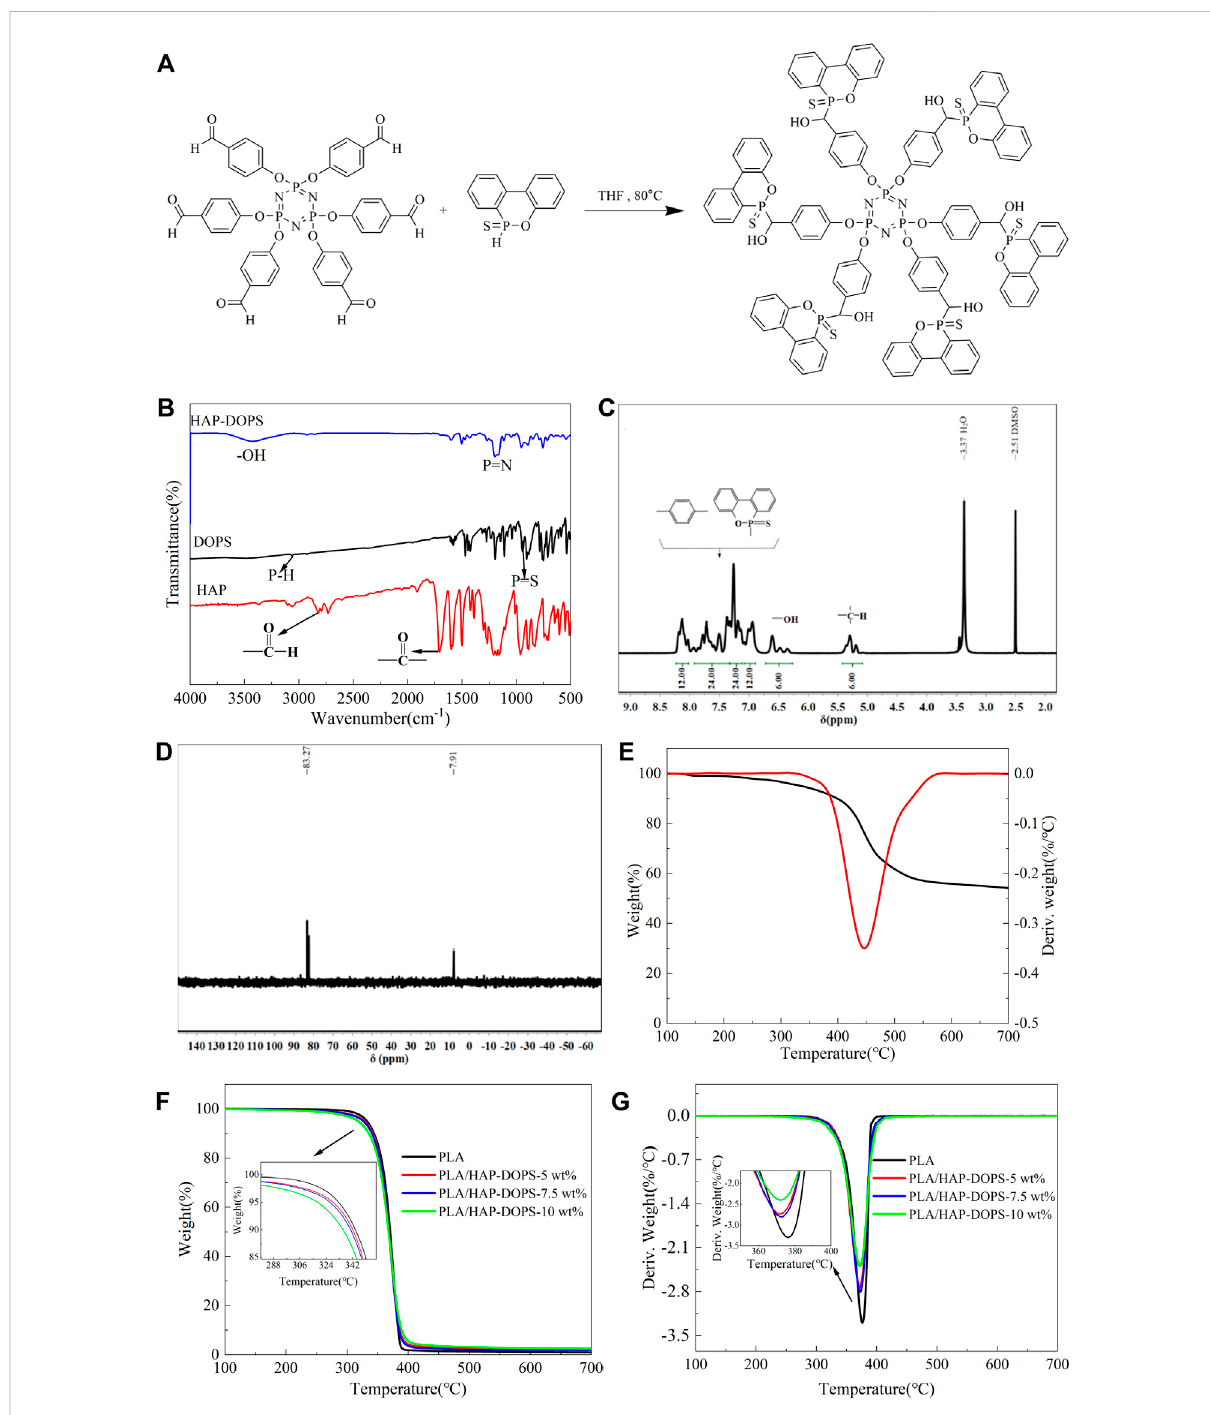
FIGURE 1 (A) Synthesisof fl ameretardantHAP-DOPSwithdoublefunctionalgroups. (B) FT-IRspectrumofthecompoundsHAP 、